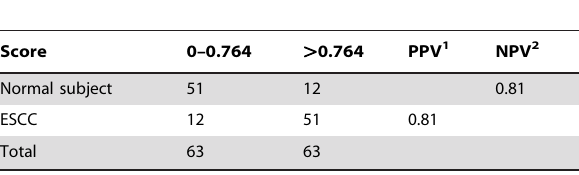
Table 2. Risk score analysis of oesophageal squamous cell carcinoma (ESCC) patients and normal